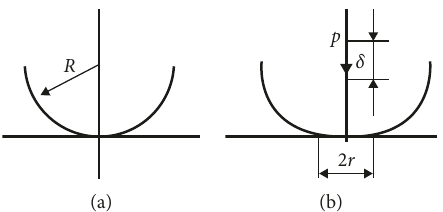
Figure 2: Schematic diagram of the contact between a microconvex body and a rigid plane. (a) Unloaded state. (b) Loaded